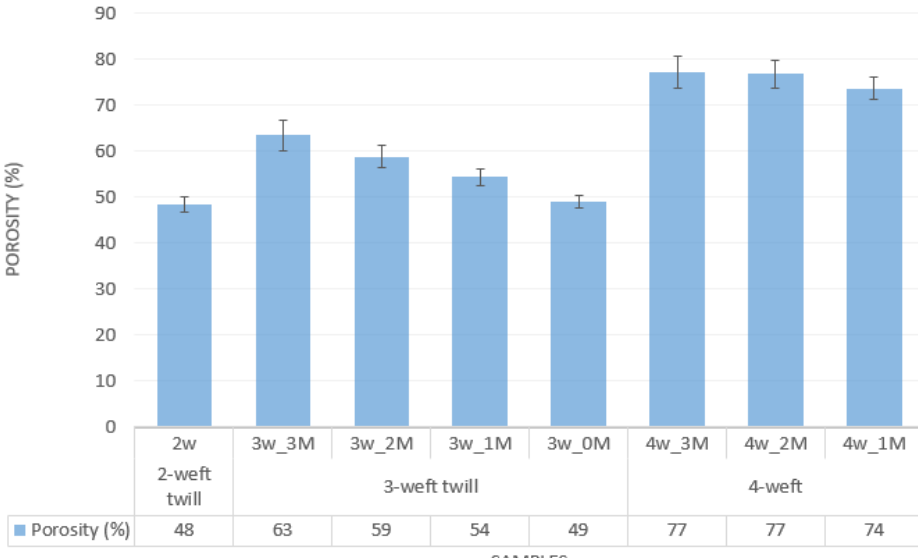
Figure 5. Volume porosity of the samples.